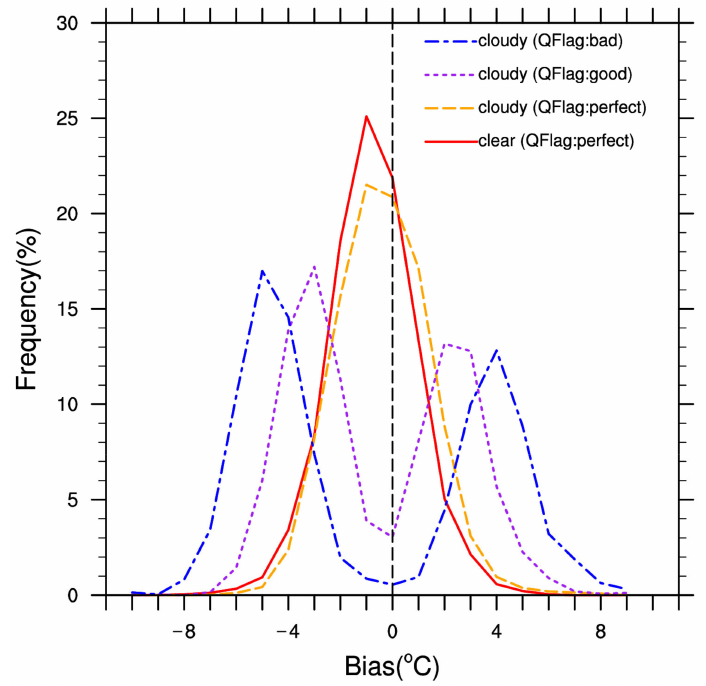
Figure 5. The occurrence frequency (%) of bias for GIIRS temperature profile products in comparison with radiosonde observations. The interval of bias is 1.0°C on the horizontal axis. The four types of GIIRS data are the perfect flagged under the clear sky (red line), the perfect flagged under the cloudy sky (orange line), the good (purple line) as well as bad (blue line) flagged under the cloudy sky.